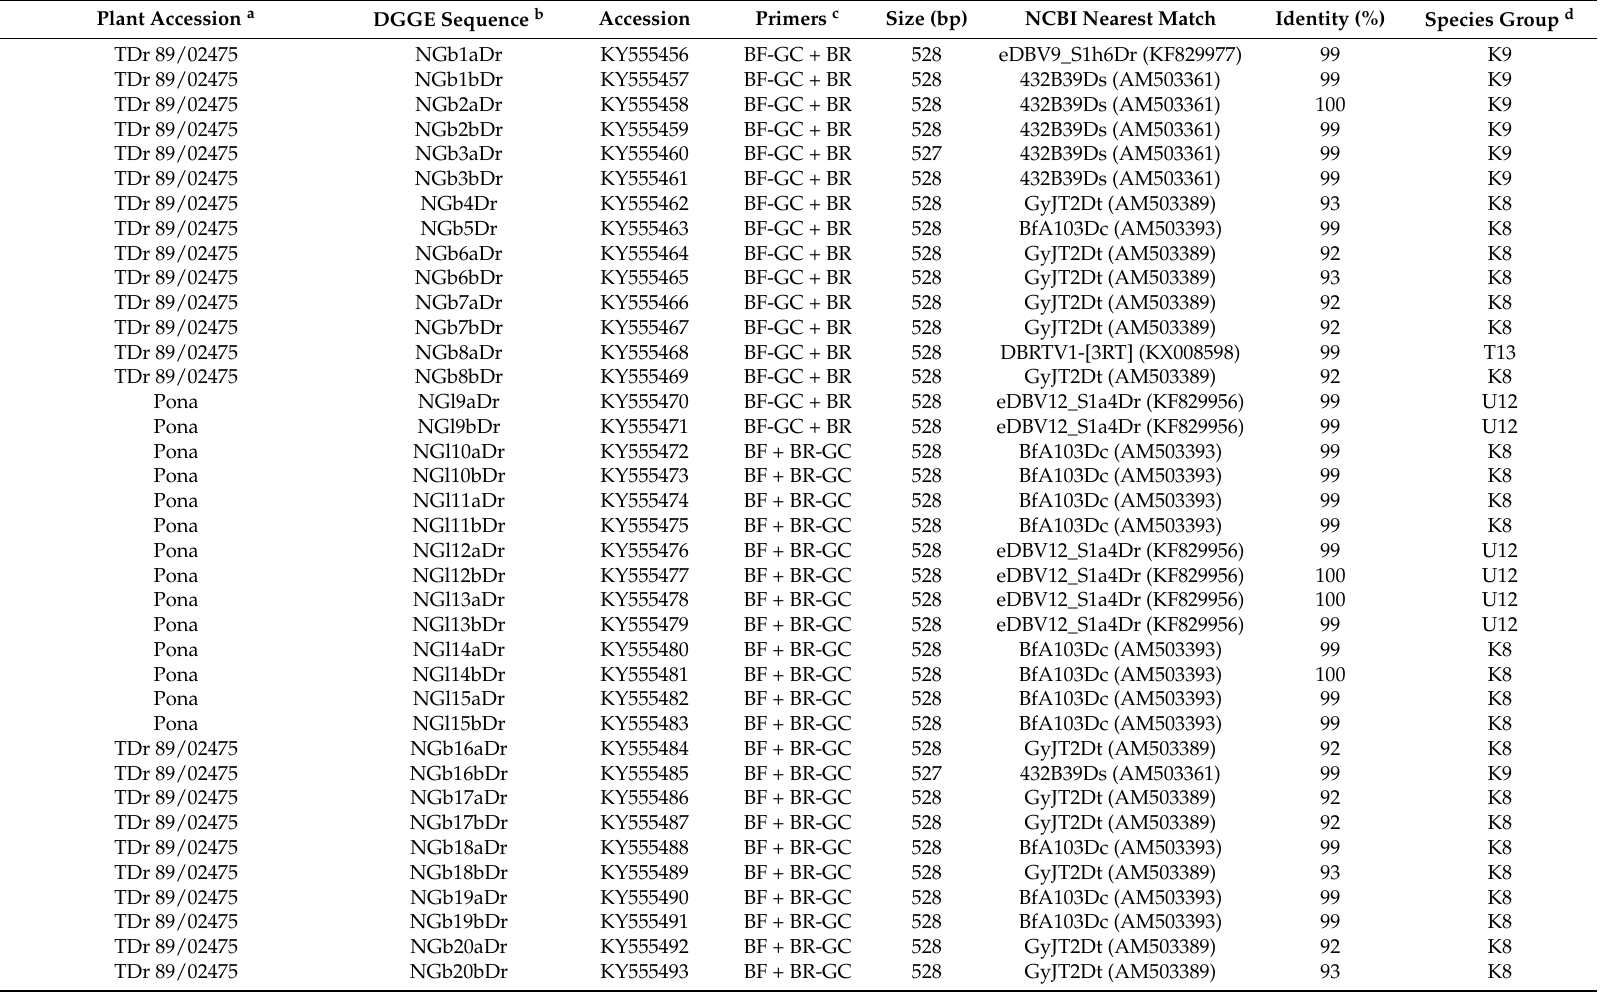
Table 1. Basic local alignment search tool (BLAST) analysis of partial RT-RNaseH sequences cloned from DGGE